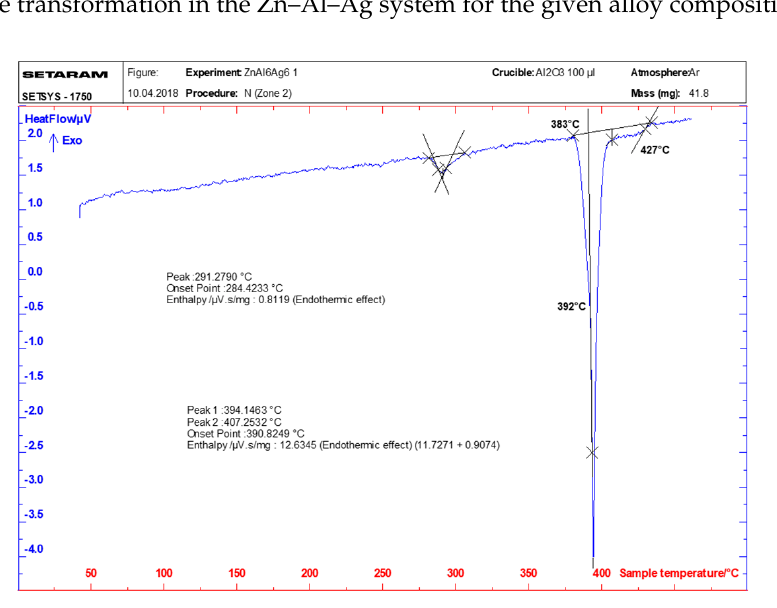
Figure 4. DTA record for the ZnAl6Ag6 alloy at a heating rate of 5 °C/min.